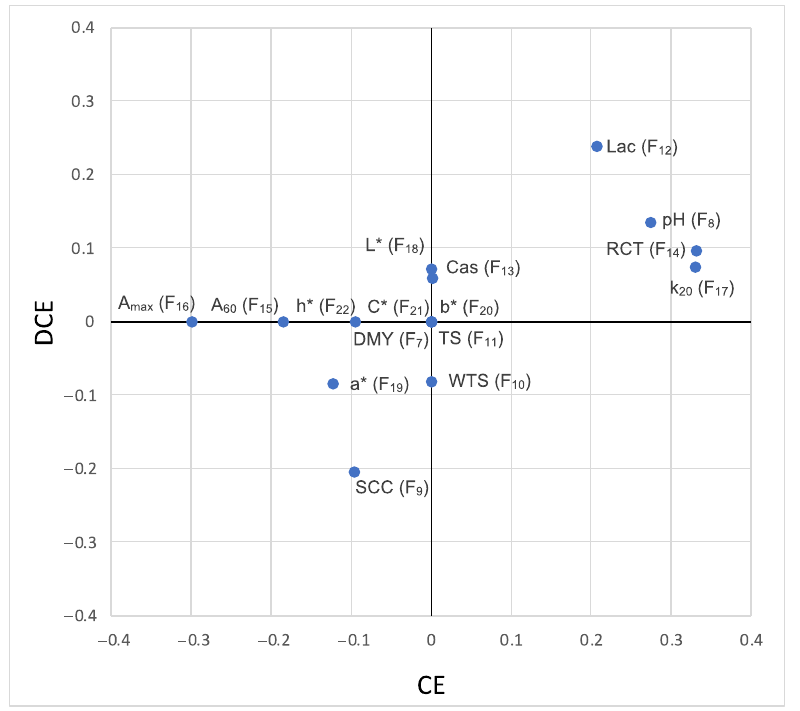
Figure 4. Bivariate associations (Pearson correlations) between curd efficiency (CE) and dry curd efficiency (DCE) and the quantitative factors evaluated ( n = 967).